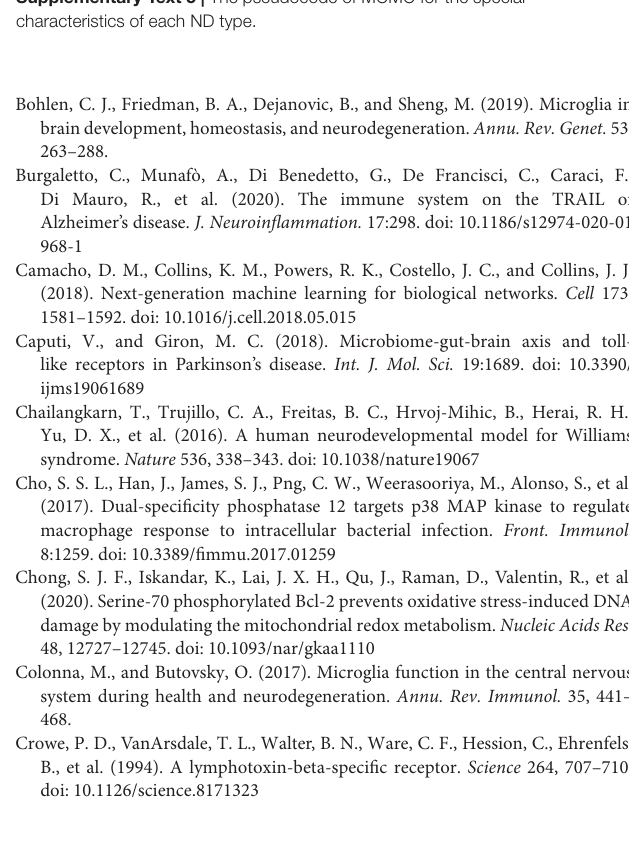
Supplementary Figure 1 | The results of the Kruskal–Wallis test for age-matched different ND samples and normal samples. (A) AD; (B) PD; (C) PSP; (D) FTD. Supplementary Figure 2 | The network marker with the highest betweenness of different ND. (A) AD; (B) PD; (C) PSP; (D) FTD. Supplementary Table 1 | The p -value of K–S test of the aging score. Supplementary Table 2 | The chronological age and aging scores of each ND group and the normal aged group (after age-matched). Supplementary Text 1 | The detailed datasets used in this work. Supplementary Text 2 | The cpg sites used in this work. Supplementary Text 3 | The selected risk markers of the aging predictor and each ND predictor, along with their ReliefF weights. Supplementary Text 4 | The pseudocode of MCMC for the common characteristics across multiple ND types. Supplementary Text 5 | The pseudocode of MCMC for the special characteristics of each ND